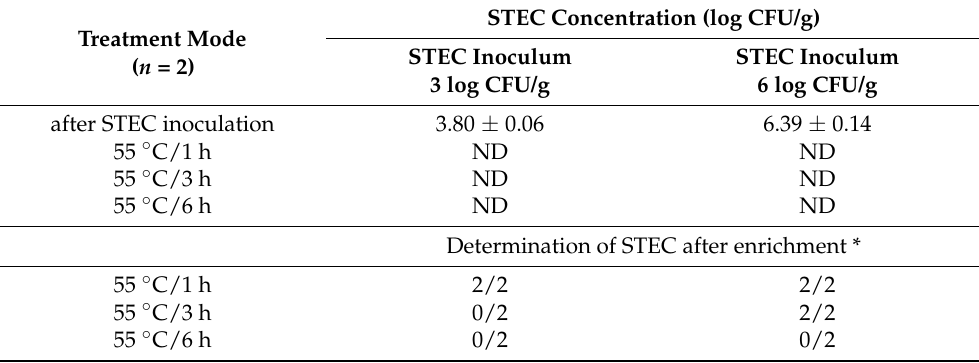
Table 3. Results for the STEC count (mean ± standard deviation) in CFU/g in the product steak tartare following artificial inoculation with a cocktail of STEC of 3 and 6 log CFU/g and following sous vide cooking at 55 ◦ C for a period of 1, 3, and 6 h. Treatment